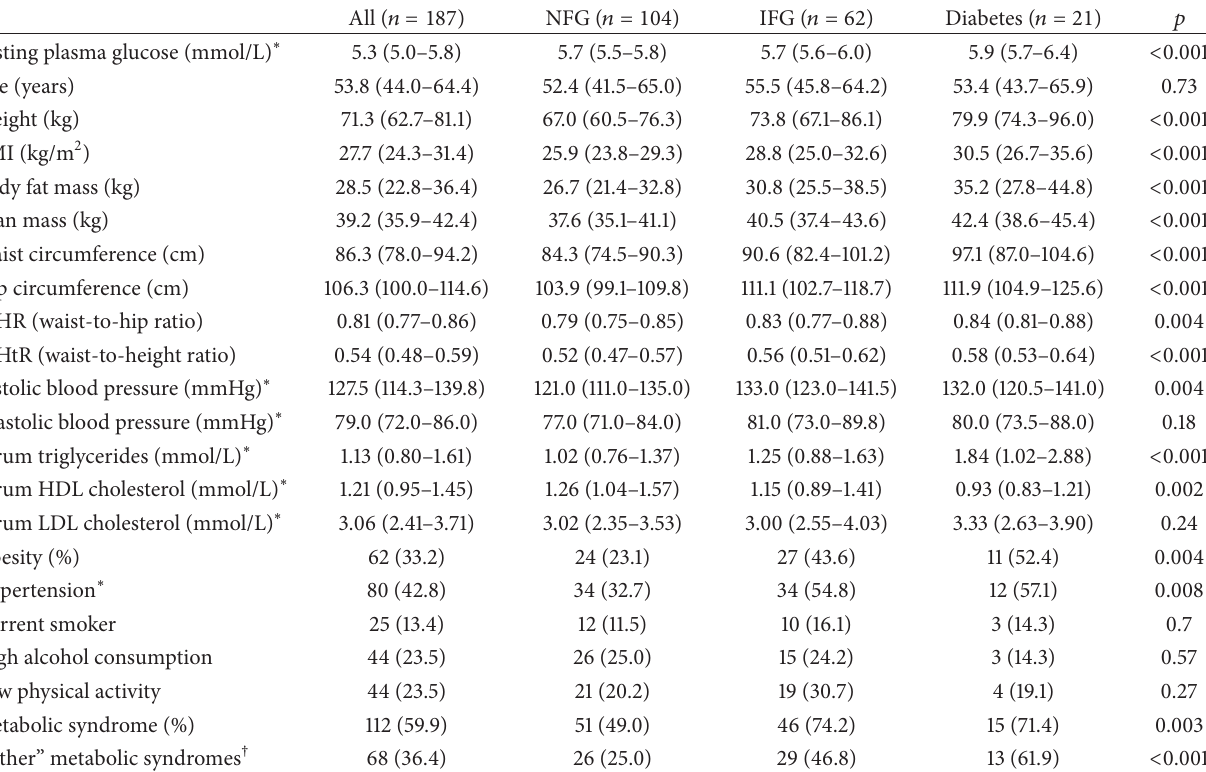
Table 2: Characteristics of subjects with impaired fasting glucose (IFG) at baseline showing those who progressed to diabetes mellitus and those who regressed to normal fasting glucose (NFG) over the decade of follow-up. Data are shown as median (interquartile range) or 𝑛 (%).